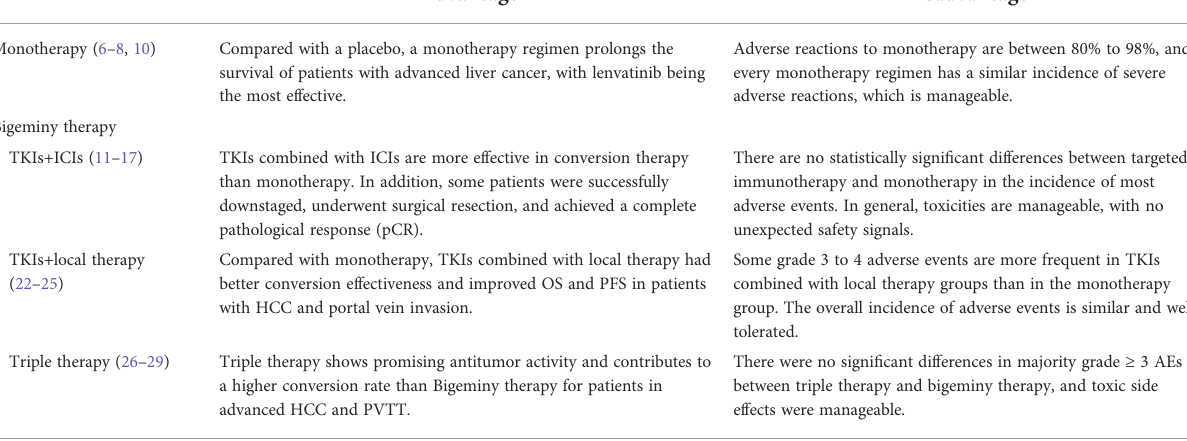
TABLE 2 Summary of the advantages and disadvantages of monotherapy and combination therapy.